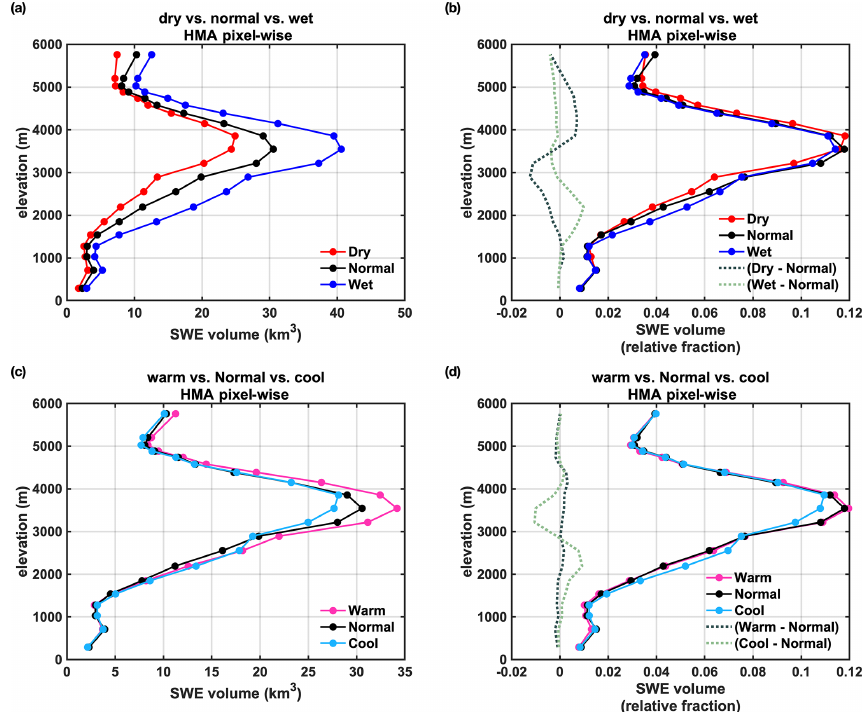
Figure 12. Cluster-averaged pixel-wise peak SWE volume (and its relative fraction, i.e., normalized with total SWE volume) distribution vs. elevation under different climate conditions in HMA. Here panels (a) and (b) show the distribution under dry, normal and wet conditions; panels (c) and (d) show the distribution under warm, normal and cool conditions. Difference curves with reference to the normal condition are also provided in panels (b) and (d) as shown with dashed